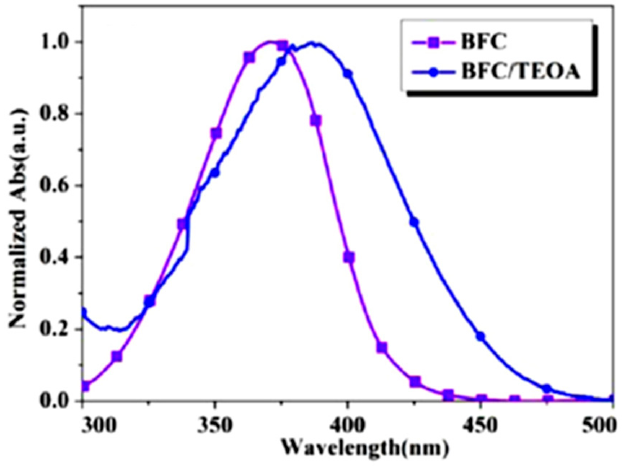
Figure 10. UV-visible absorption spectra of BFC and [BFC/TEOA] CTC . Reproduced with permission of Ref. [167] .